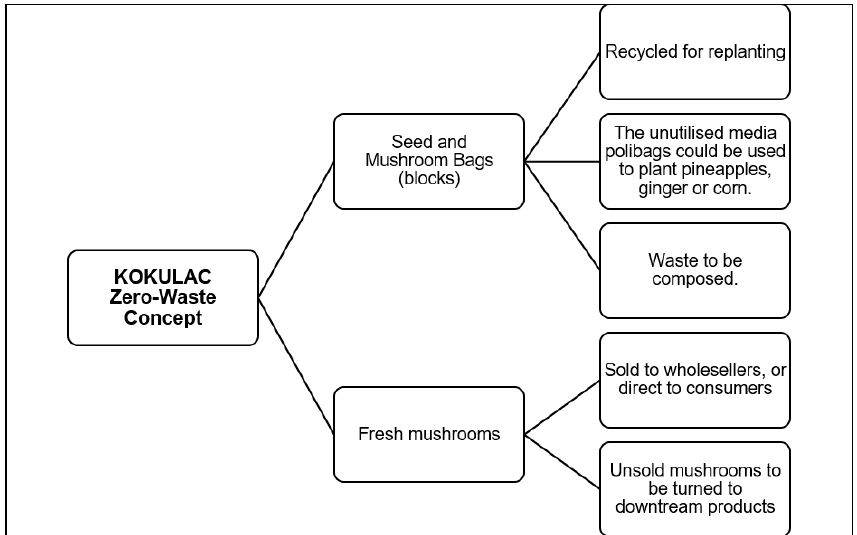
Figure 3. The KOKULAC zero-waste operational system.